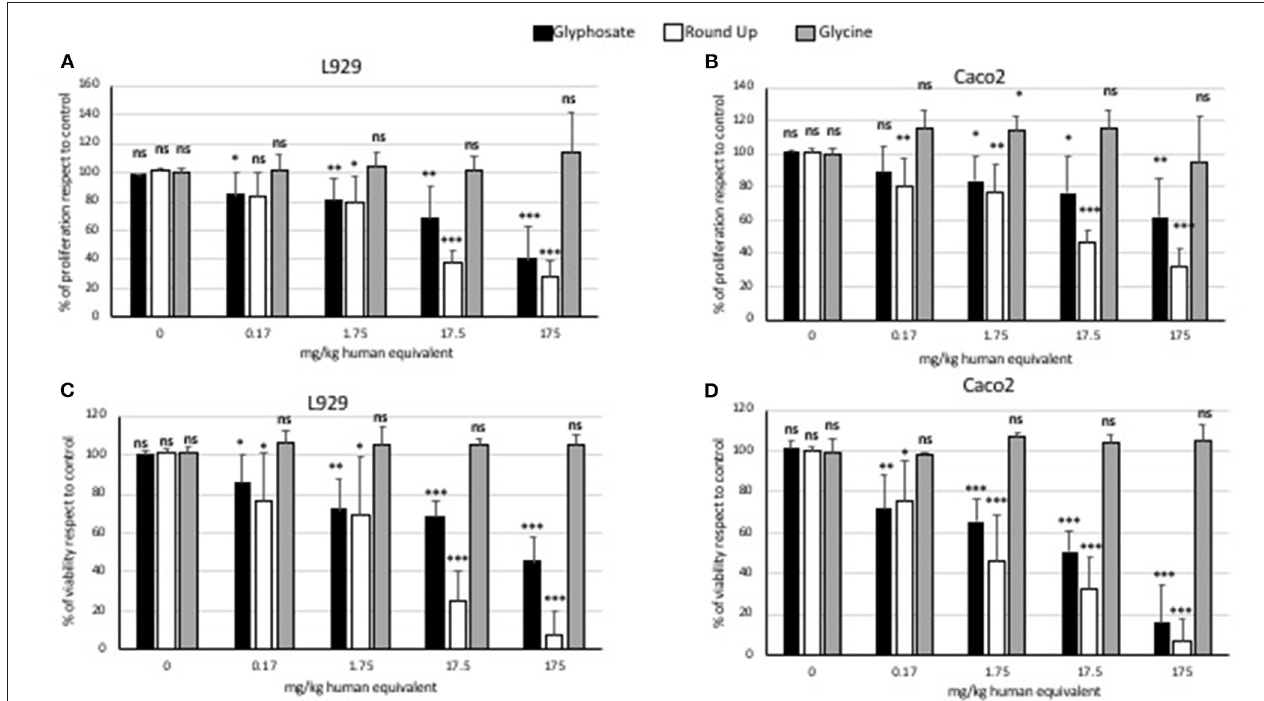
FIGURE 1 | MTT (proliferation) assay and Trypan Blue (viability) assay: effects of pure glyphosate, Roundup Bioflow, and glycine at the dose range 0–175mg kg − 1 (human equivalent) on cell proliferation of L929 fibroblasts (A) , Caco2 cells (B) , and on cell viability of L929 fibroblasts (C) and Caco2 cells (D) . Data are expressed as mean value ( ± st. dev.) (% compared to control). Pairwise comparison based on Anova (Dunnett test). ns, not significant: * P < 0.05; ** P < 0.01; *** P < 0.001.